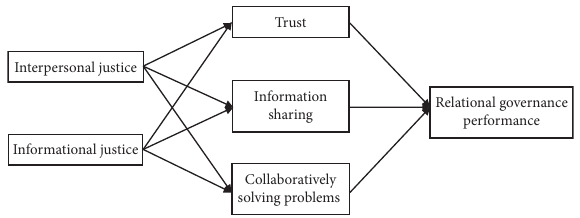
Figure 1: Model of relations between interactive justice, relational embeddedness, and governance